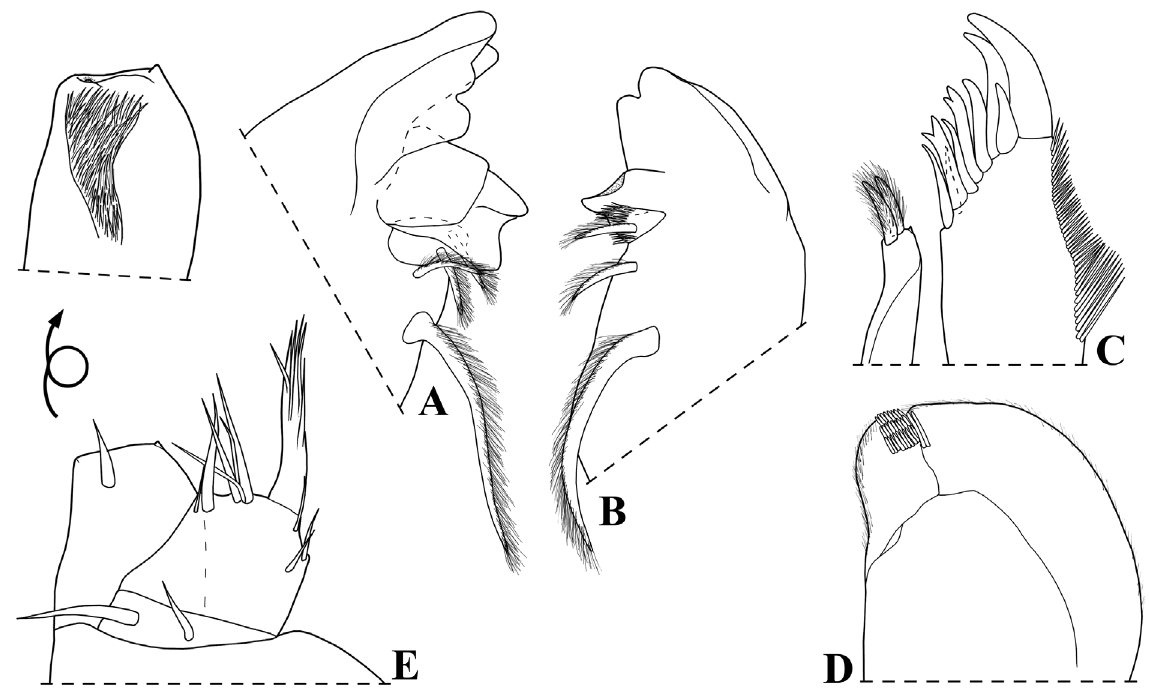
Fig. 9. Metaprosekia igatuensis Campos-Filho, Fernandes & Bichuette sp. nov., ♀, paratype (LES 6349). A . Left mandible. B . Right mandible. C . Maxillula. D . Maxilla. E .